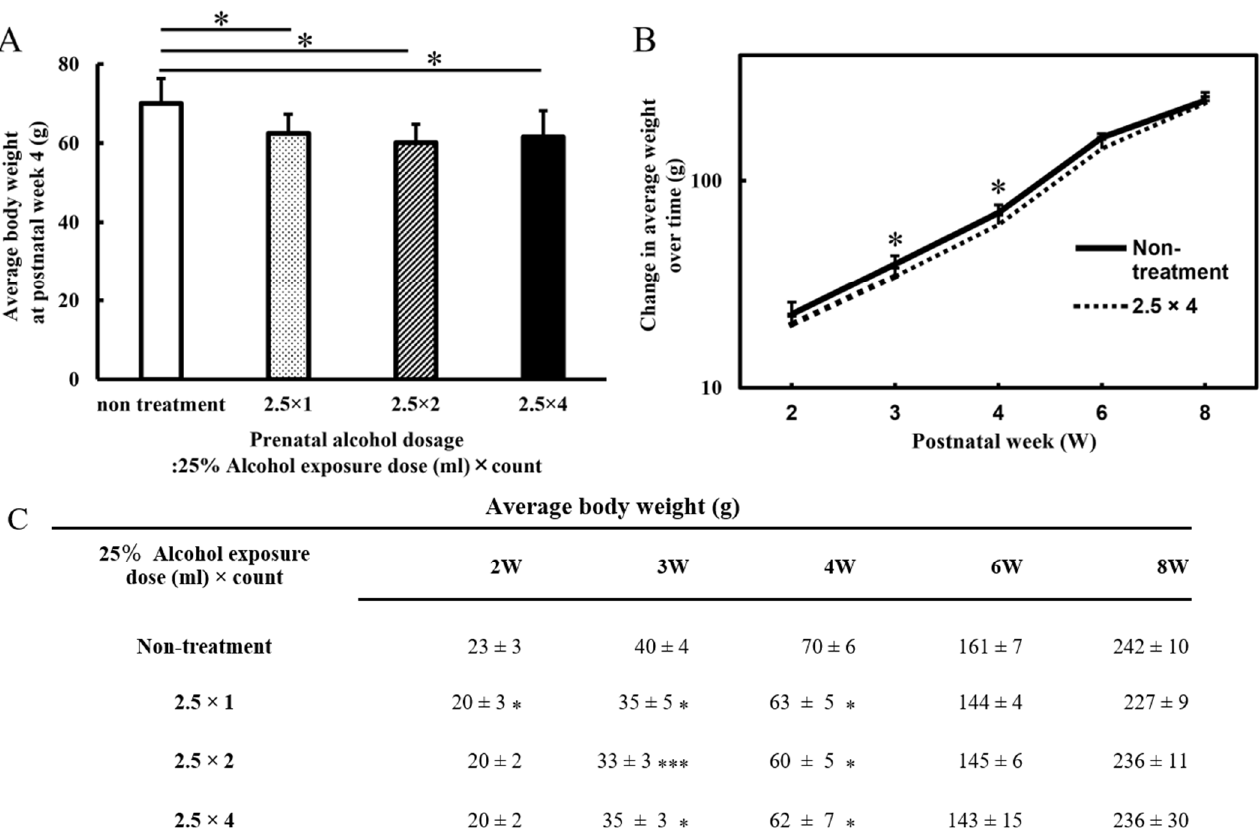
Figure 1. The graph of body weight (g) at postnatal week 4 (postnatal days 28) ( A ). The graph of body weight (g) from the second postnatal week (postnatal days 14) to adulthood (postnatal days 56) ( B ). ( A ) The graph is a four-group comparison (n = 7~11) of the non-treatment, 2.5 × 1, 2.5 × 2, and 2.5 × 4 groups. All FASD groups showed the same weight loss compared with that of the non-treated group at 4 weeks of age ( p < 0.05). ( B ) Comparison between the non-treated and four-dose alcohol groups (2.5 × 4: n = 11). At 3 and 4 weeks of age, the four-dose group had lower body weights than the control group did; no significant differences were observed at 8 weeks of age ( p < 0.05). ( C ) The table of body weight (g) from the second postnatal week (p14) to adulthood (p56). Low body weights were observed in all FASD groups compared with controls at 3 and 4 weeks of